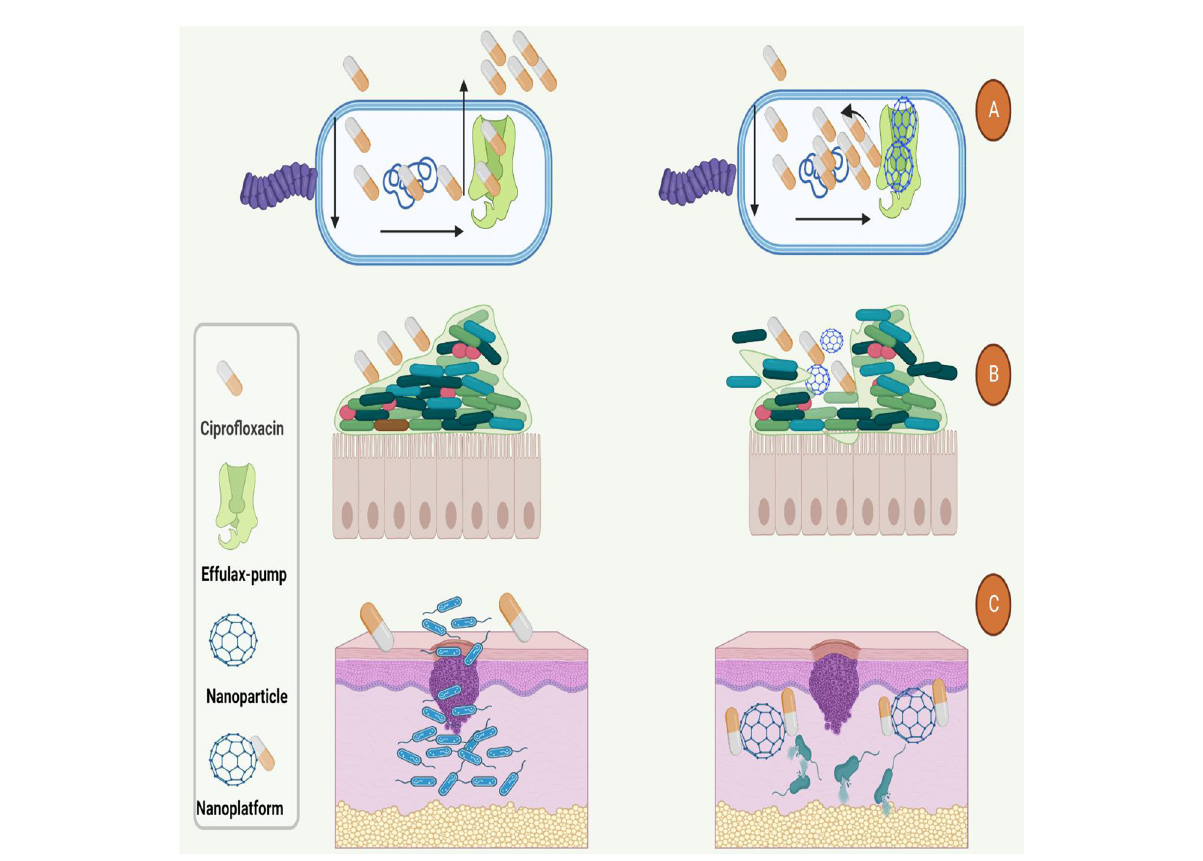
FIGURE4 Used nano-platforms for enhancement of ciprofloxacin efficacy against bacteria. (A) Nanoparticles could boost the antibacterial function of ciprofloxacin by inhibition of efflux-pumps. (B) Nanoparticles increase the antibacterial activity and penetration of ciprofloxacin to the (B) dipper layers of biofilm and (C) body organs such as the